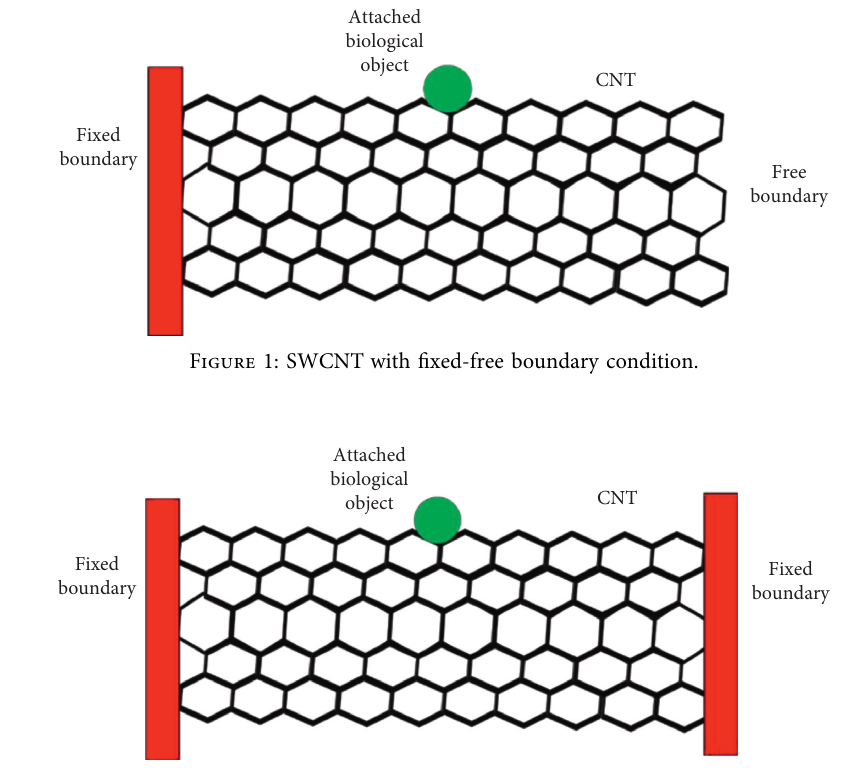
Figure 2: SWCNT with fixed-fixed boundary